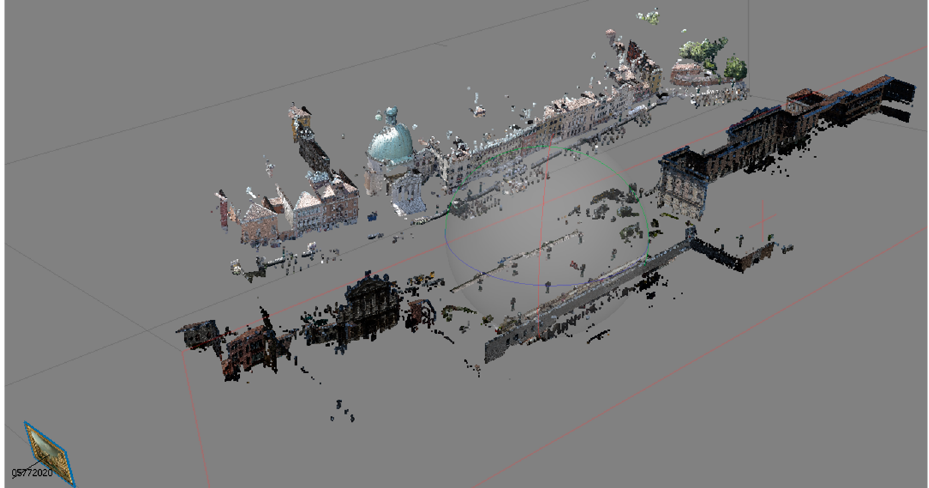
Figure 18. Orientation of the grip center of the painting related to a view on the dense cloud.